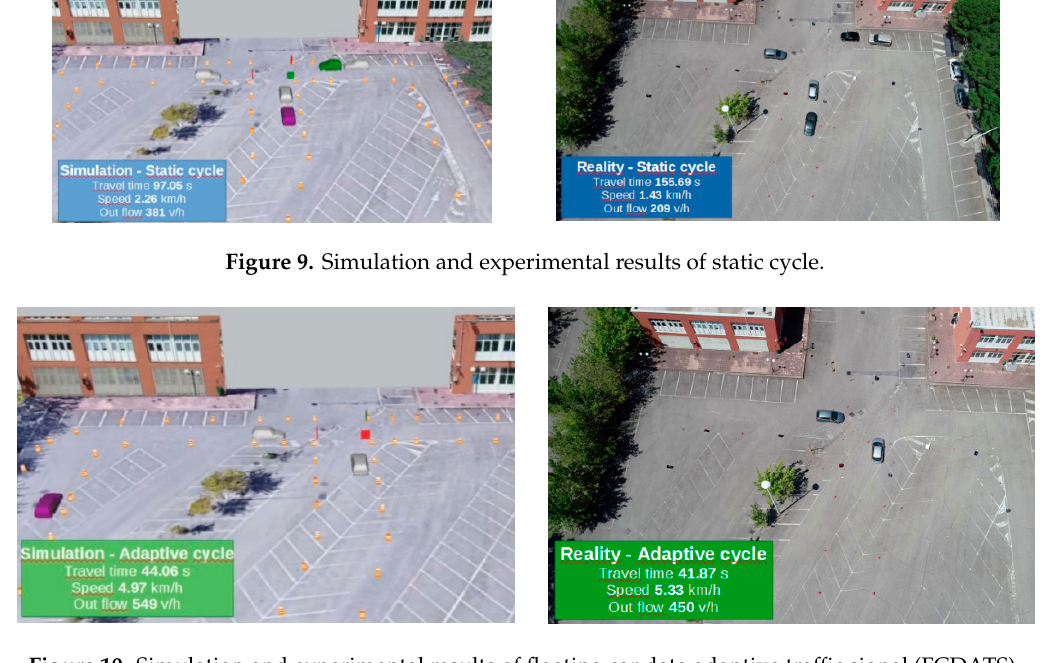
Table 3. Simulation results for maneuver.